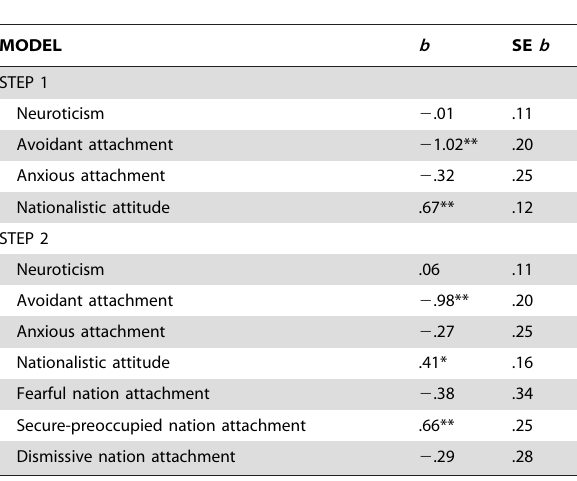
Table 7. Association of Nation Attachment with Heritage Culture Endorsement (Study 2).